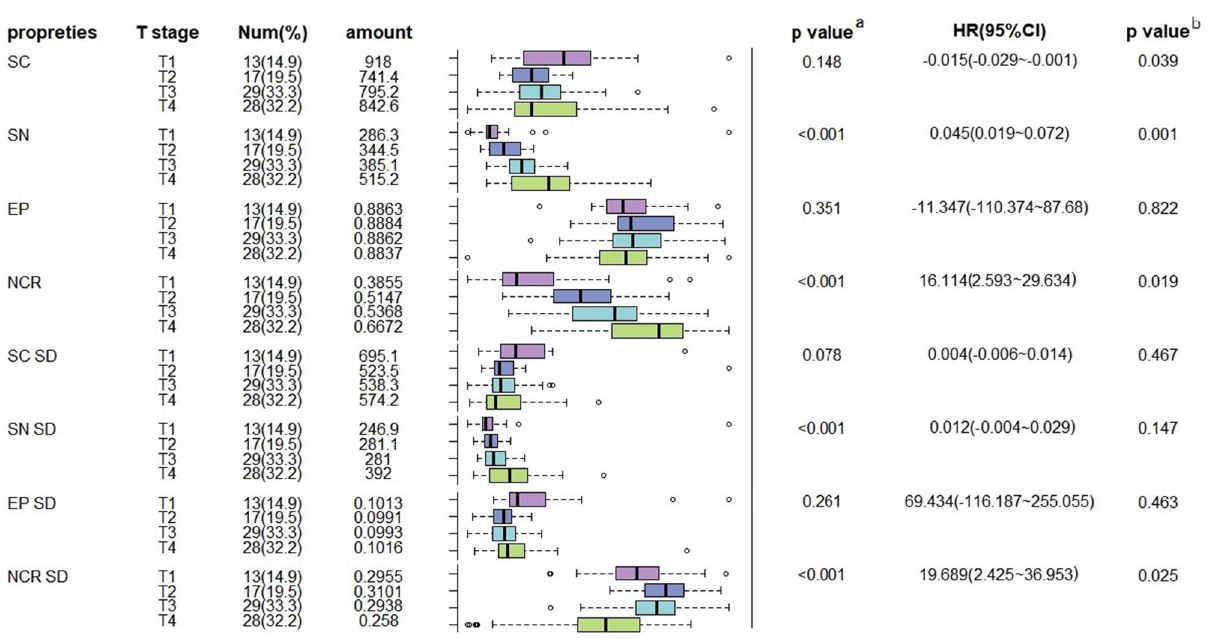
Figure 3. Univariate and multivariate analysis of the relationship between lymph node involvement and the depth of invasion in stomach SRCC. SC Cell area (pixel); SN Nucleus area (pixel); Ep Ellipticity; NCR Nuclear- plasma ratio; SD Standard deviation. #a calculated by Kruskal–Wallis test; b calculated by multiple ordered logistic regression, p < 0.05 was considered to be